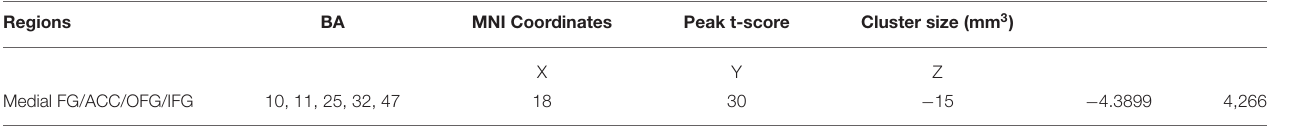
TABLE 2 | Group differences in inter-hemispheric FC between healthy controls and MDD patients. Regions BA MNI Coordinates Peak t-score Cluster size (mm 3 ) X Y Z Medial FG/ACC/OFG/IFG 10, 11, 25, 32, 47 18 30 − 15 − 4.3899